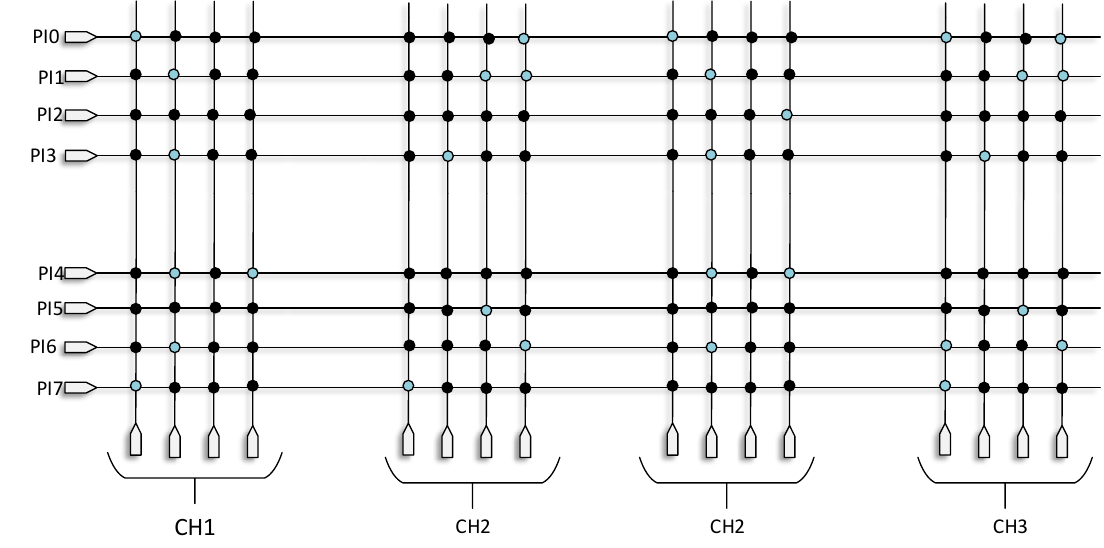
Figure 7. Connection box (CB1) internal